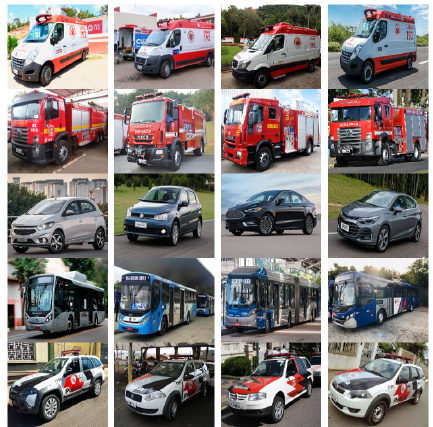
Figure 3. Images of the database created and its subcategories (left).